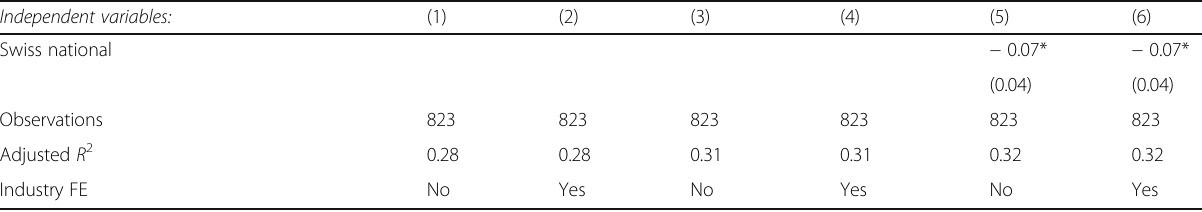
Table 3 Determinants of the use of income replacement (Continued) Independent